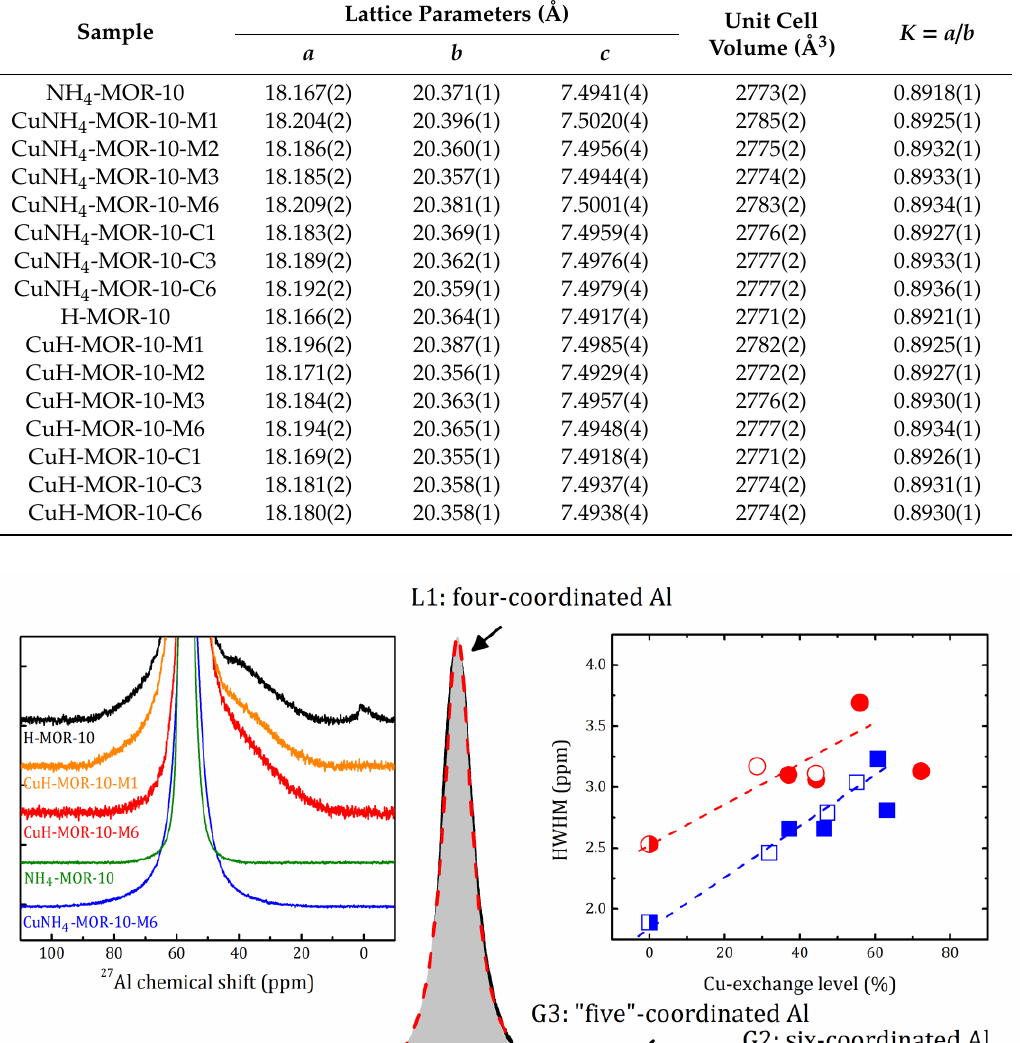
Table 2. Lattice parameters, unit cell volume, and a / b ratio for the studied samples before and after the ion-exchange procedure.